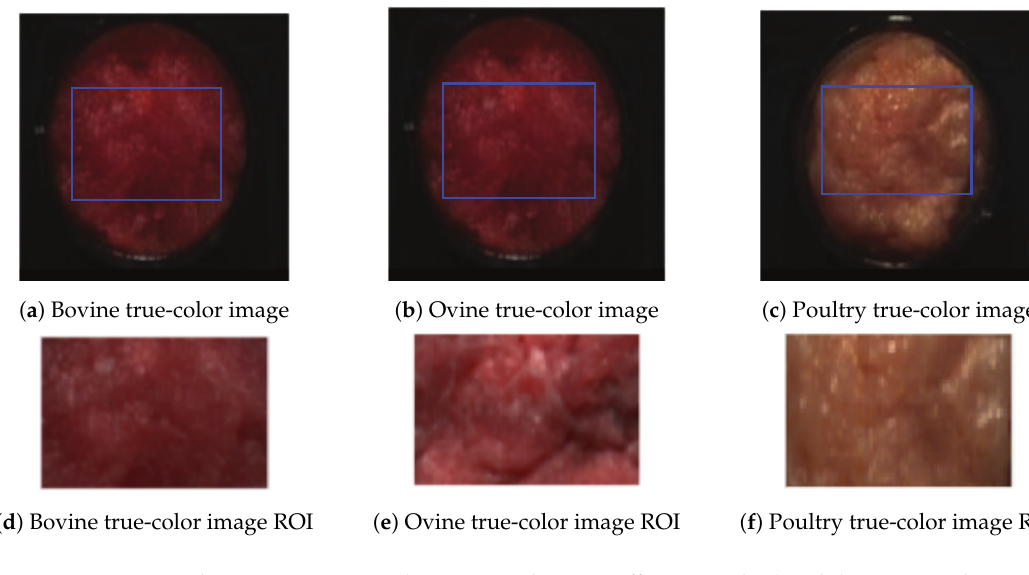
Figure 2. True-color images generated using correlation coefficient method and the generated ROIs.